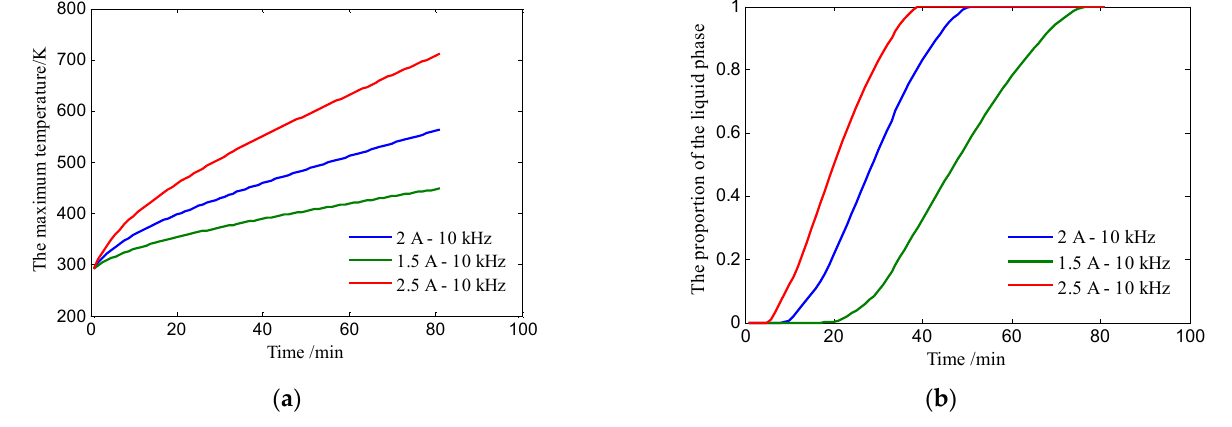
Figure 10. The performance with different current amplitude. ( a ) The maximum temperature in the explosive. ( b ) The proportion of the liquid phase.